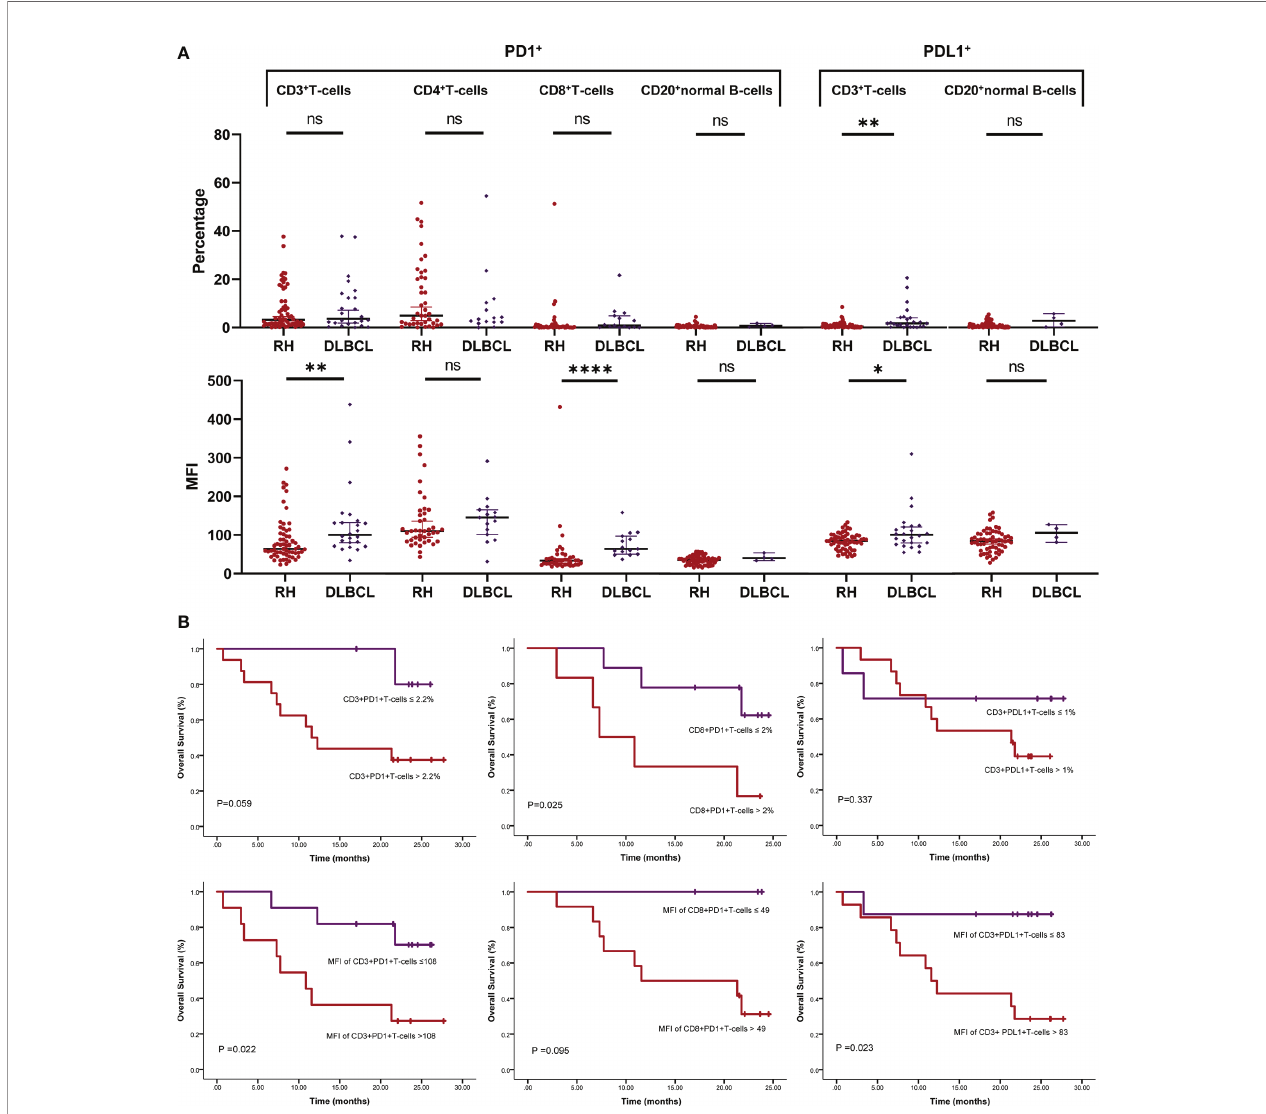
FIGURE 2 | PD1/PDL1 status in tumor-in fi ltrating lymphocytes (TILs) in diffuse large B-cell lymphoma (DLBCL). (A) Scatter plots depicting PD1/PDL1 status in reactive hyperplasia (RH) and diffuse large B-cell lymphoma (DLBCL). *P < 0.05; **P < 0.005; ****P < 0.0001. (B) Prognostic value of PD1/PDL1 status of TILs in DLBCL. ns, no signi fi